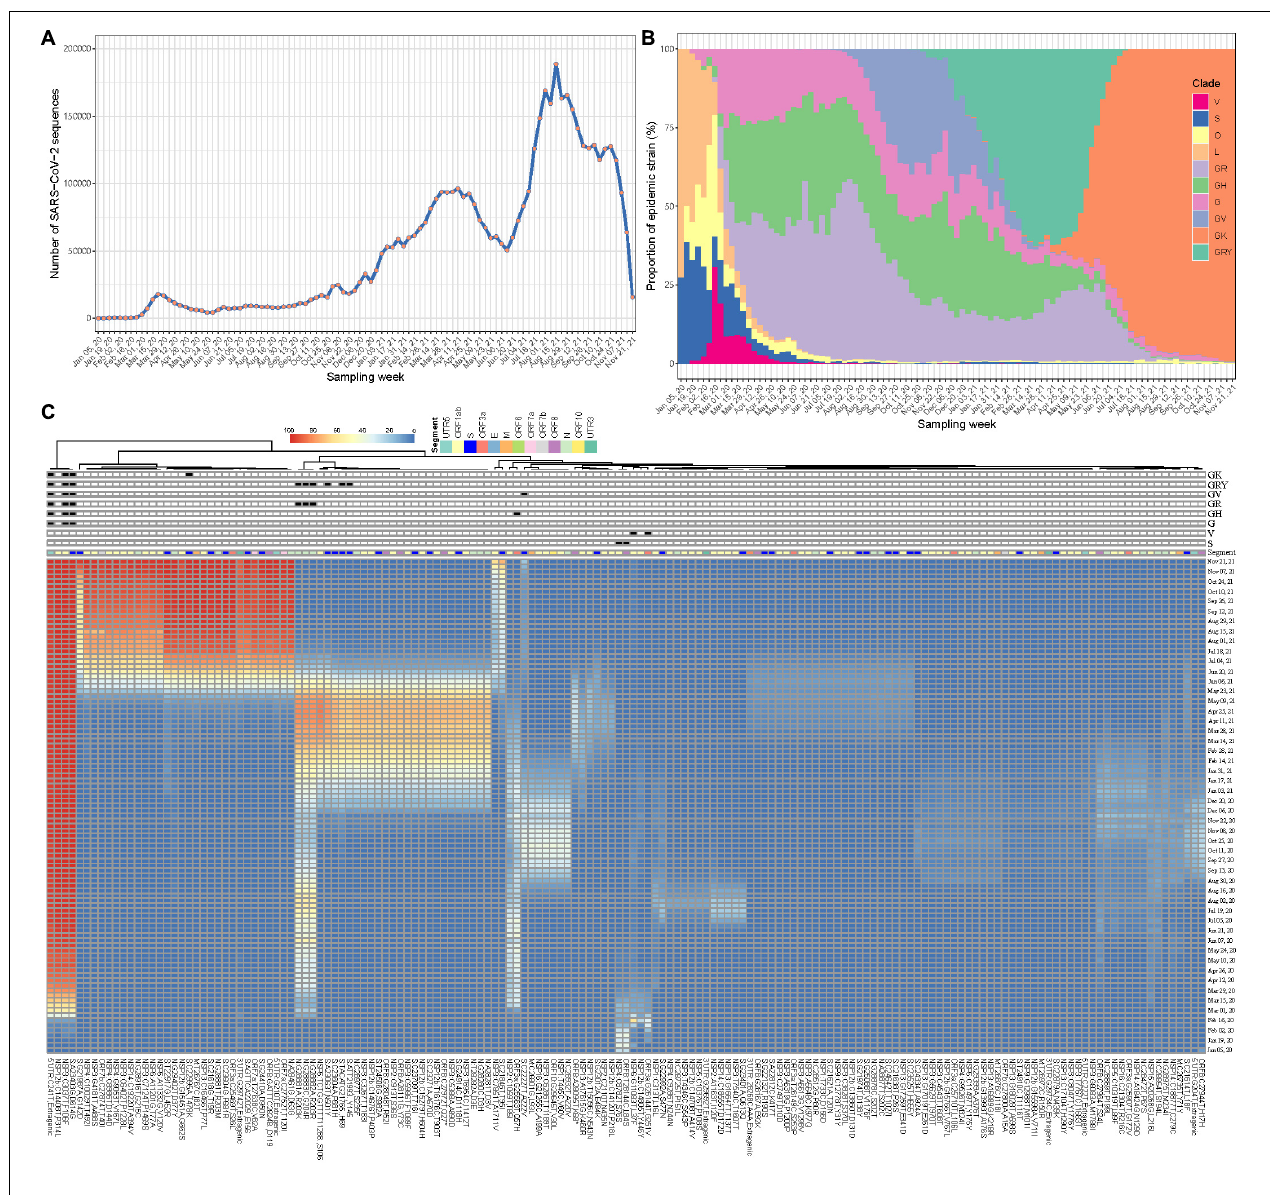
FIGURE 2 | Synchronous temporal changes between variant-specific FTMs and variant prevalence. (A) Weekly distribution of SARS-CoV-2 genome sequences according to sampling time. (B) Time course of major variant distribution in collected sequences. (C) A Wald’s linkage hierarchical cluster tree of frequency trajectories of mutations. One hundred and fifty-eight mutations passing filtration were analyzed, annotated and displayed. Variant-specific mutations were